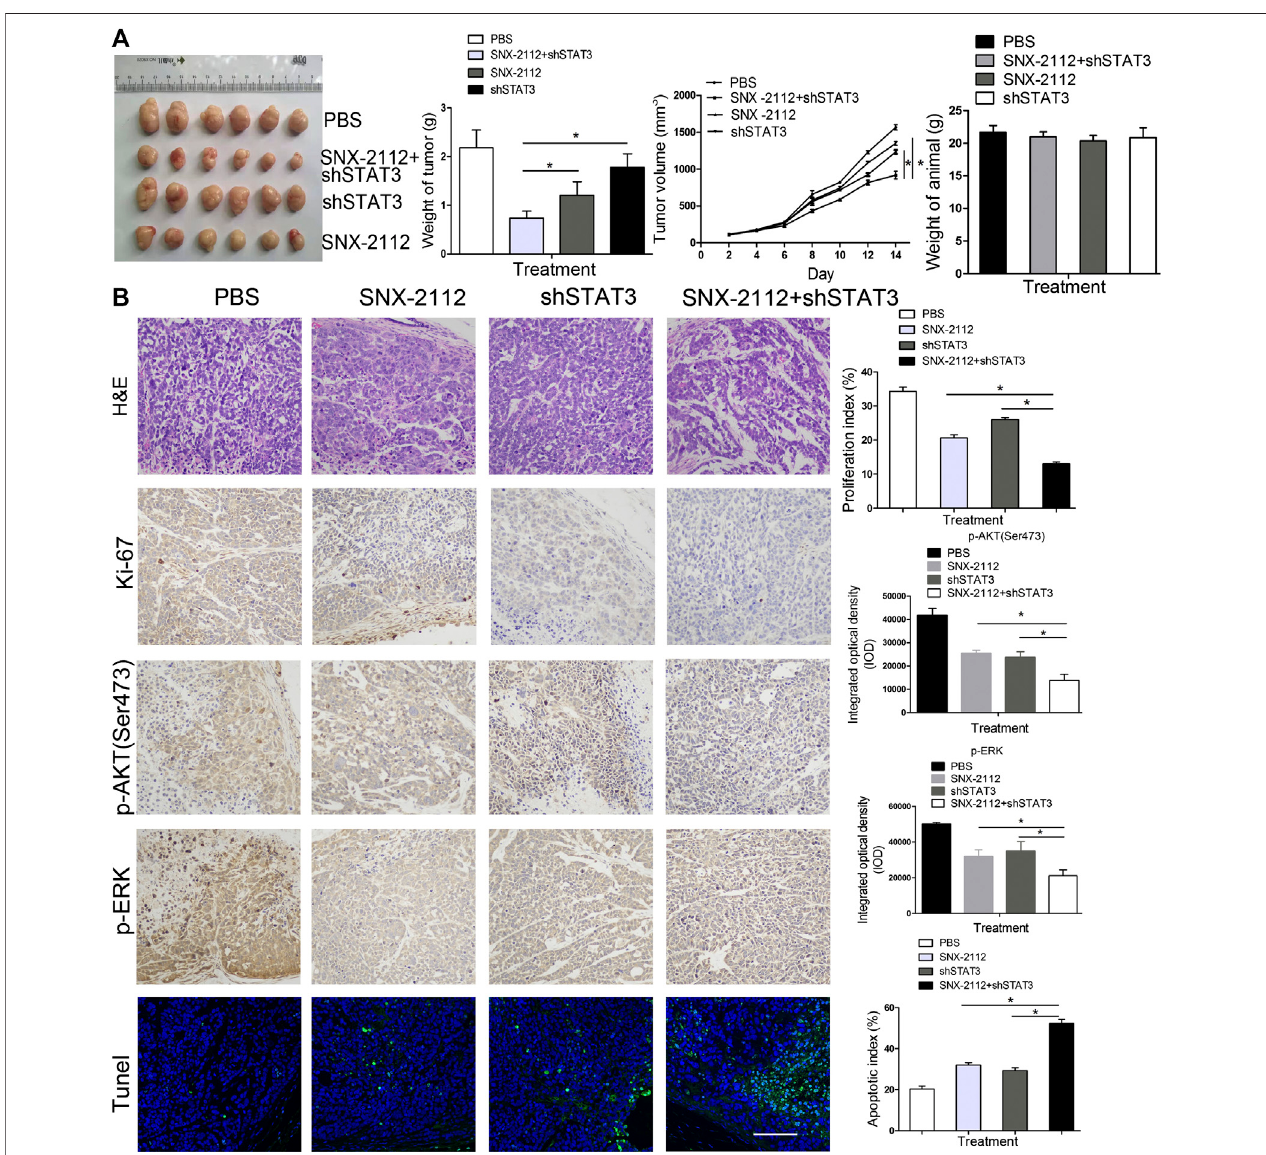
FIGURE 5 | The inhibition of tumorigenicity of ECSLCs by SNX-2112 with shSTAT3 in vivo (A) Analysis of tumor weight and animal weight. Balb/c nude mice were injected subcutaneously with 1 × 105 ECSLCs transduced with shSTAT3. After 7 days, 10 mg/kg SNX-2112 was intraperitoneally injected into mice. Every other day, the mice were administrated with SNX-2112. Following drug treatment for 2 weeks, animals from each group were euthanized, and the tumors were harvested and measured.Vertical barsrepresentmean ± SD. (B) ExpressionofKi-67, p -AKT (Ser473) and p -ERKproteins inparaf fi nsections ofECSLCsxenografts analyzed by immunocytochemistry. Sections were counter-stained with hematoxylin (blue nuclei). Representative images of various tumor tissue sections were present. TUNEL analysis of cell apoptosis was present. Scale bar, 100 μ m.